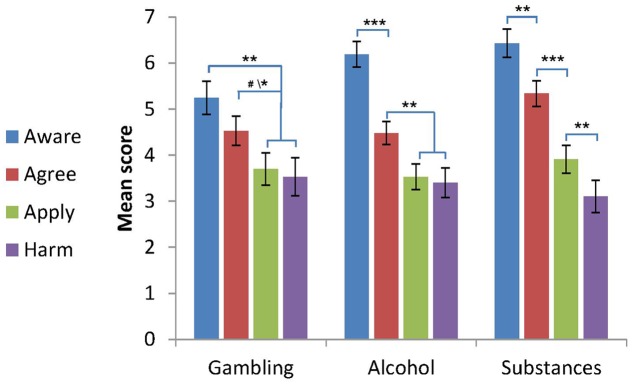
Self-stigma scores by group (M ± SE, gender, age, education level and addiction severity were controlled for). Notations: The figure shows the progressive patterns of stage scores for each group. Gambling: aware = agree > apply = harm. Alcohol: aware > agree > apply = harm. Other substances: aware > agree > apply > harm. ∗p < 0.05, ∗∗p < 0.01, ∗∗∗p < 0.001, #p < 0.06, compared to the signed stages in each group (for the gambling group, p < 0.06 for the agree-apply difference, p < 0.05 for the agree-harm difference).